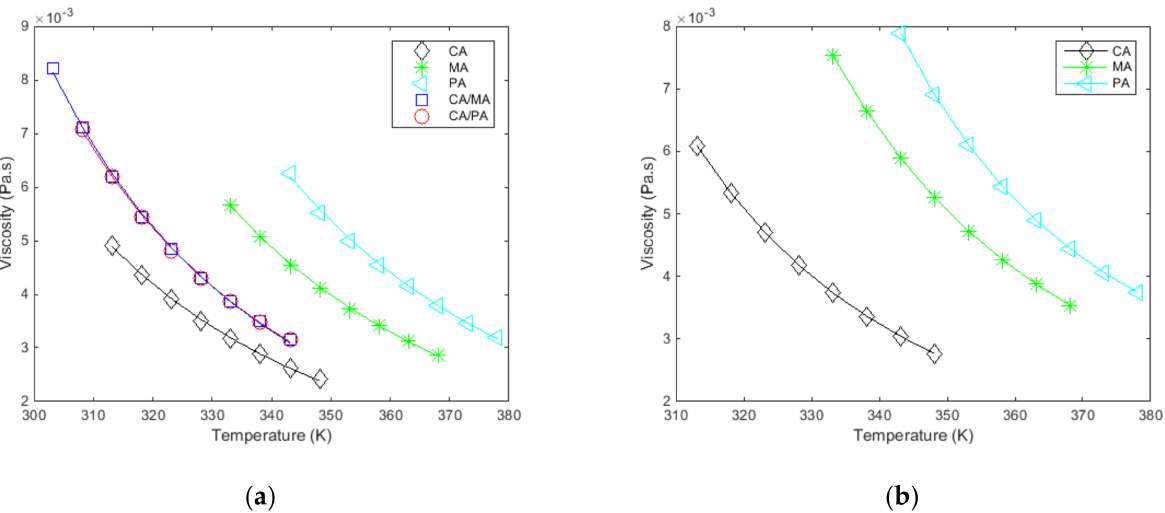
Figure 4. ( a ). Measured and fitted viscosities ( η ) as a function of the temperature ( T ), at a constant shear rate (100 s − 1 ), for the studied materials. ( b ). Results from [62] for the 3 pure fatty acids.